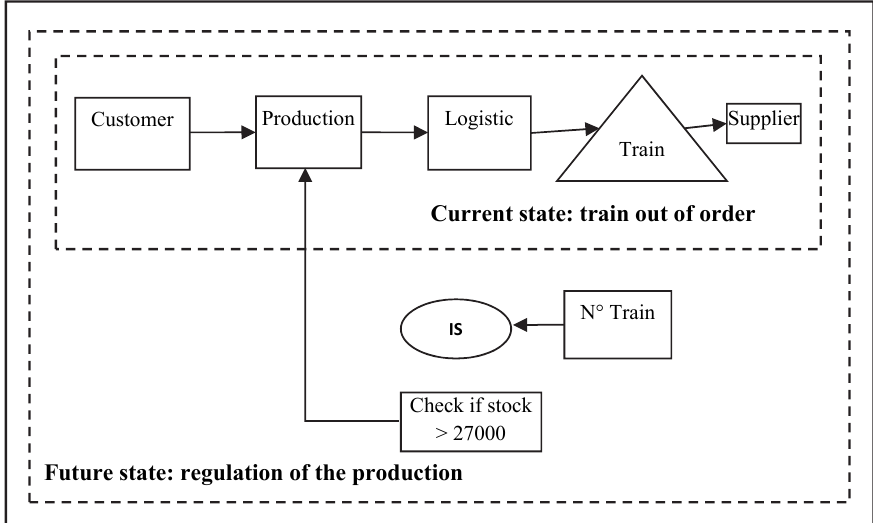
Fig. 2. Cost reduction of storage by avoiding an